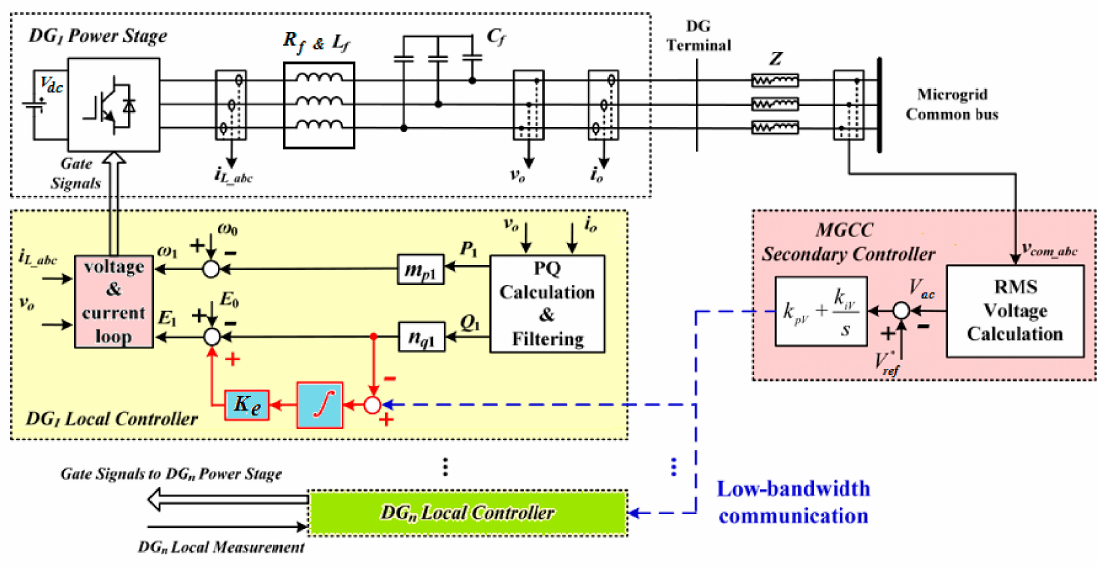
Figure 3. Block diagram of the DG control